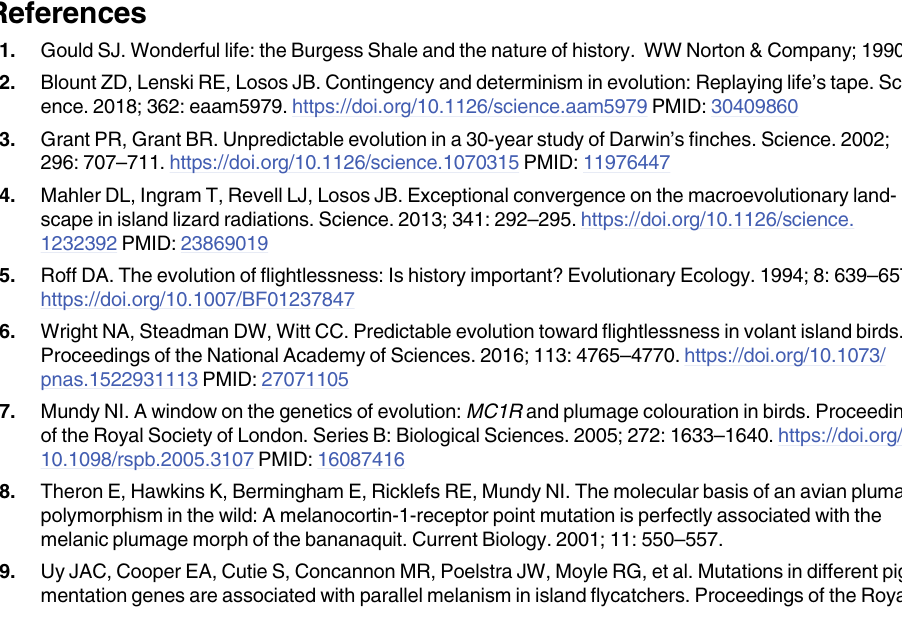
S11 Fig. Genome-wide estimates of selection coefficients and time of selection onset. Predic- tions are based on all the variants from the 190 scaffolds longer than 100kb. (TIF) S1 Data. File containing the numerical data underlying the figures in the manuscript.